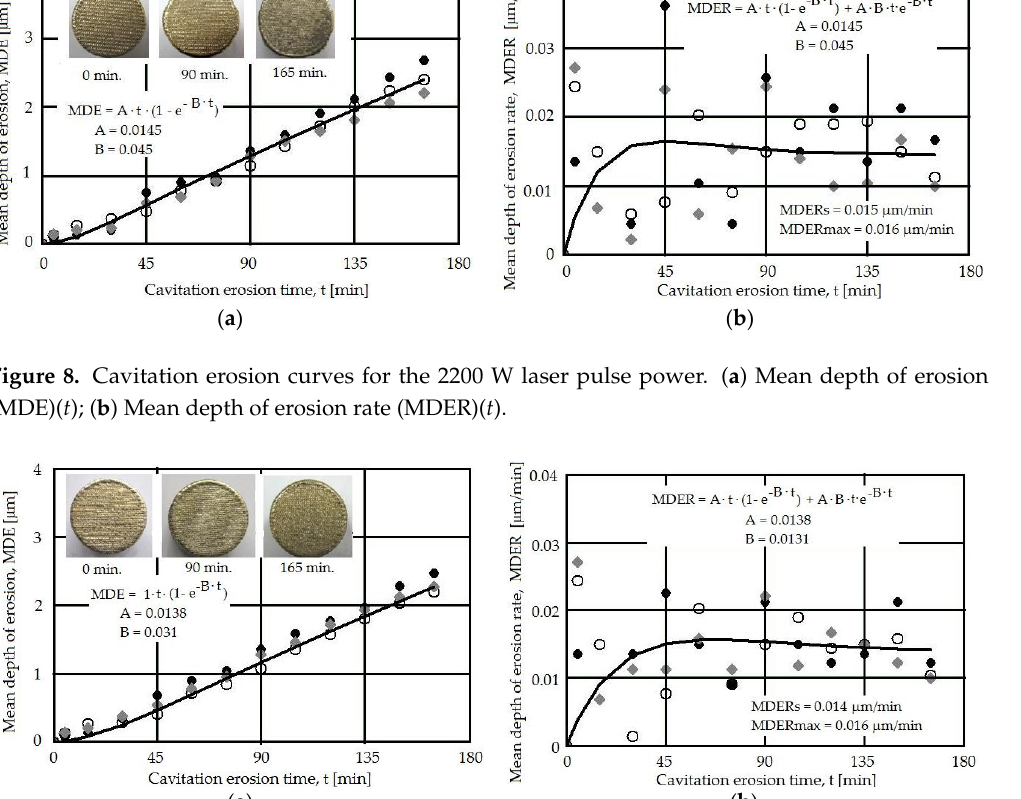
Figure 9. Cavitation erosion curves for the 2600 W laser pulse power. ( a ) MDE( t ); and ( b ) MDER( t ).